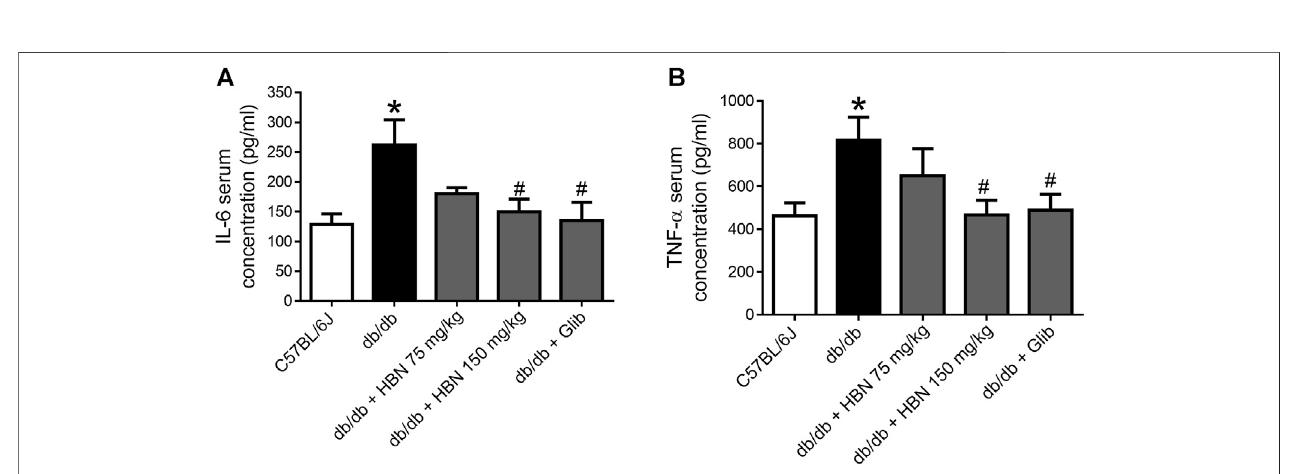
FIGURE 4 | Effects of HBN on serum pro-in fl ammatory cytokines. The level of pro-in fl ammatory cytokines of (A) IL-6 and (B) TNF- α in blood serum in C57BJ/L6 mice and db/db mice after treatment with HBN (75 and 150 mg/kg) and glibenclamide (1 mg/kg). Results are mean ± SEM of six experiments. * p < 0.05 compared to C57BL/6J mice, # p < 0.05 compared to db/db